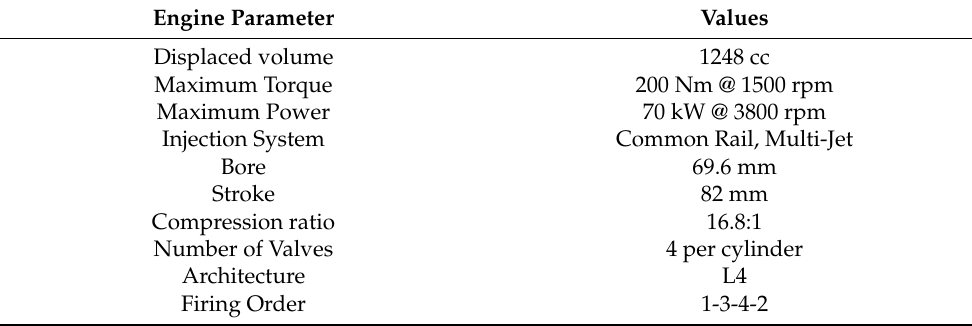
Table 1. Engine technical